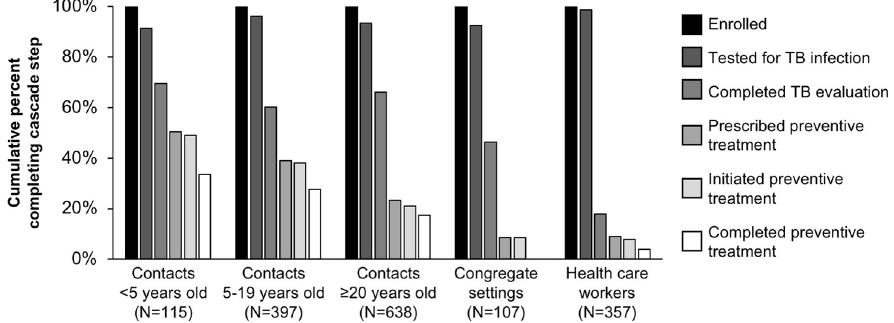
Fig 3. TB preventive treatment care cascade for contacts, people in congregate settings, and health care workers. Cumulative completion of each cascade step is calculated by calculating the percent who completed each step out of those eligible to complete it and then multiplying these